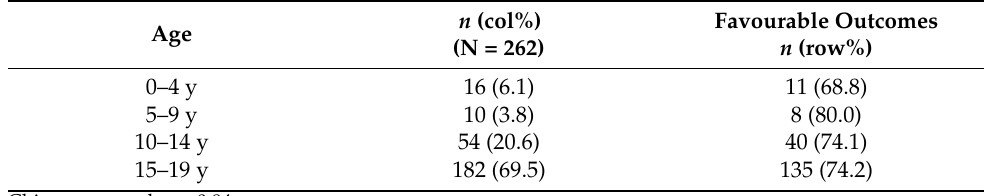
Table 2. DR-TB Treatment outcomes by age groups observed amongst child and adolescent TB patients at a tertiary care hospital in Karachi, Pakistan between January 2014 and December 2019 (N = 262).